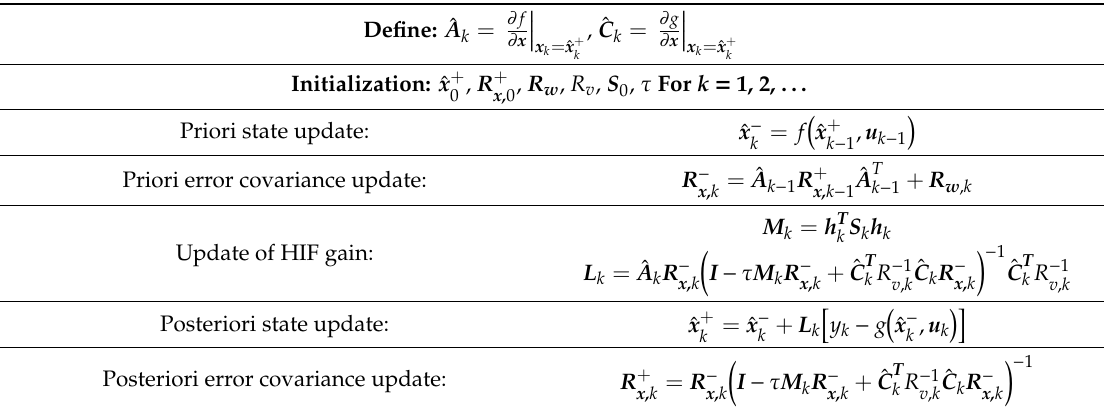
Table 1. Procedures for adopting the H-infinity